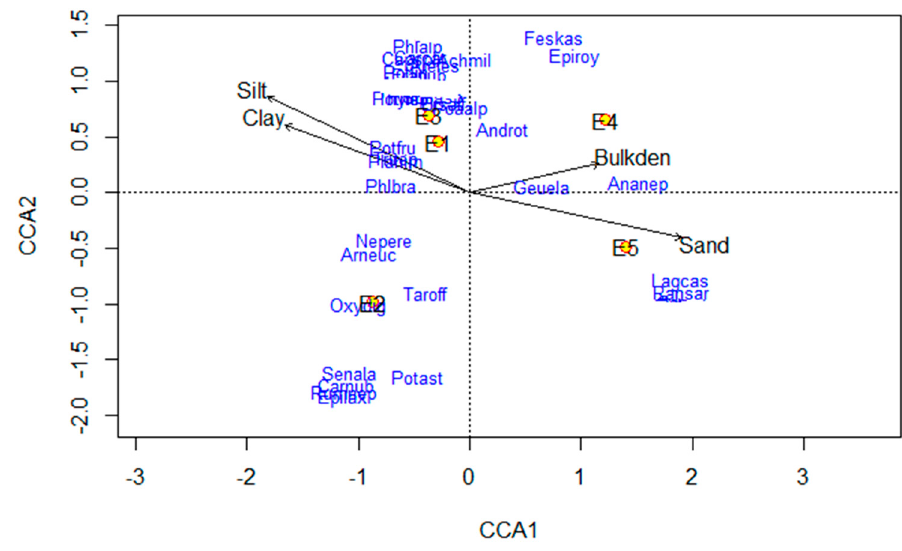
Figure 3. CCA between soil parameters and herb distribution at disturbed sites.